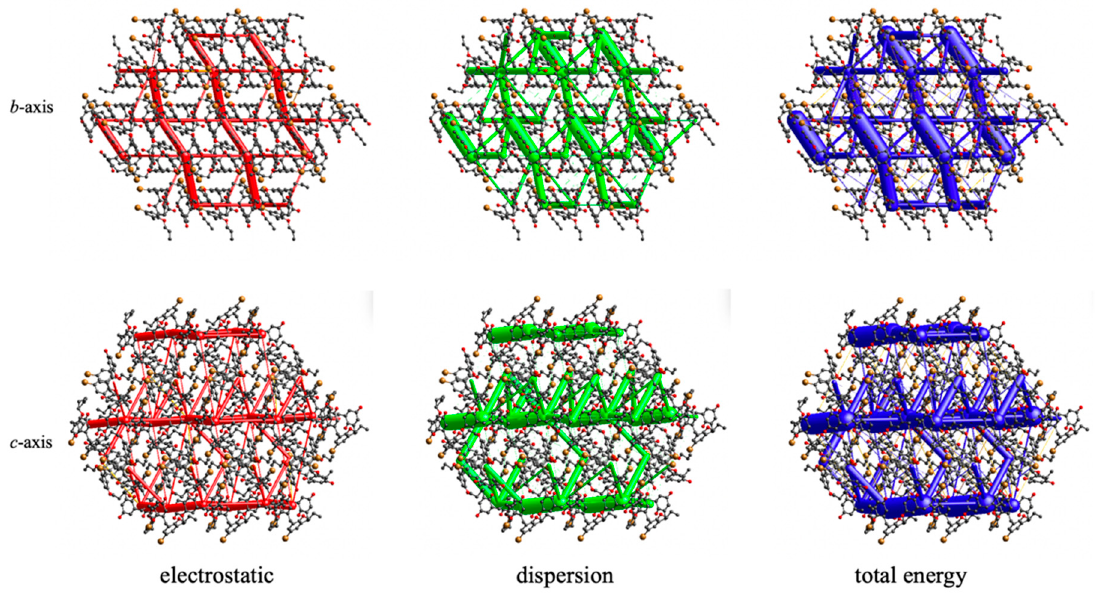
Figure 11. Energy-framework diagrams for E ele , E dis and E tot for a cluster of molecules in the crystal structure of 1 along b - and c -axes.